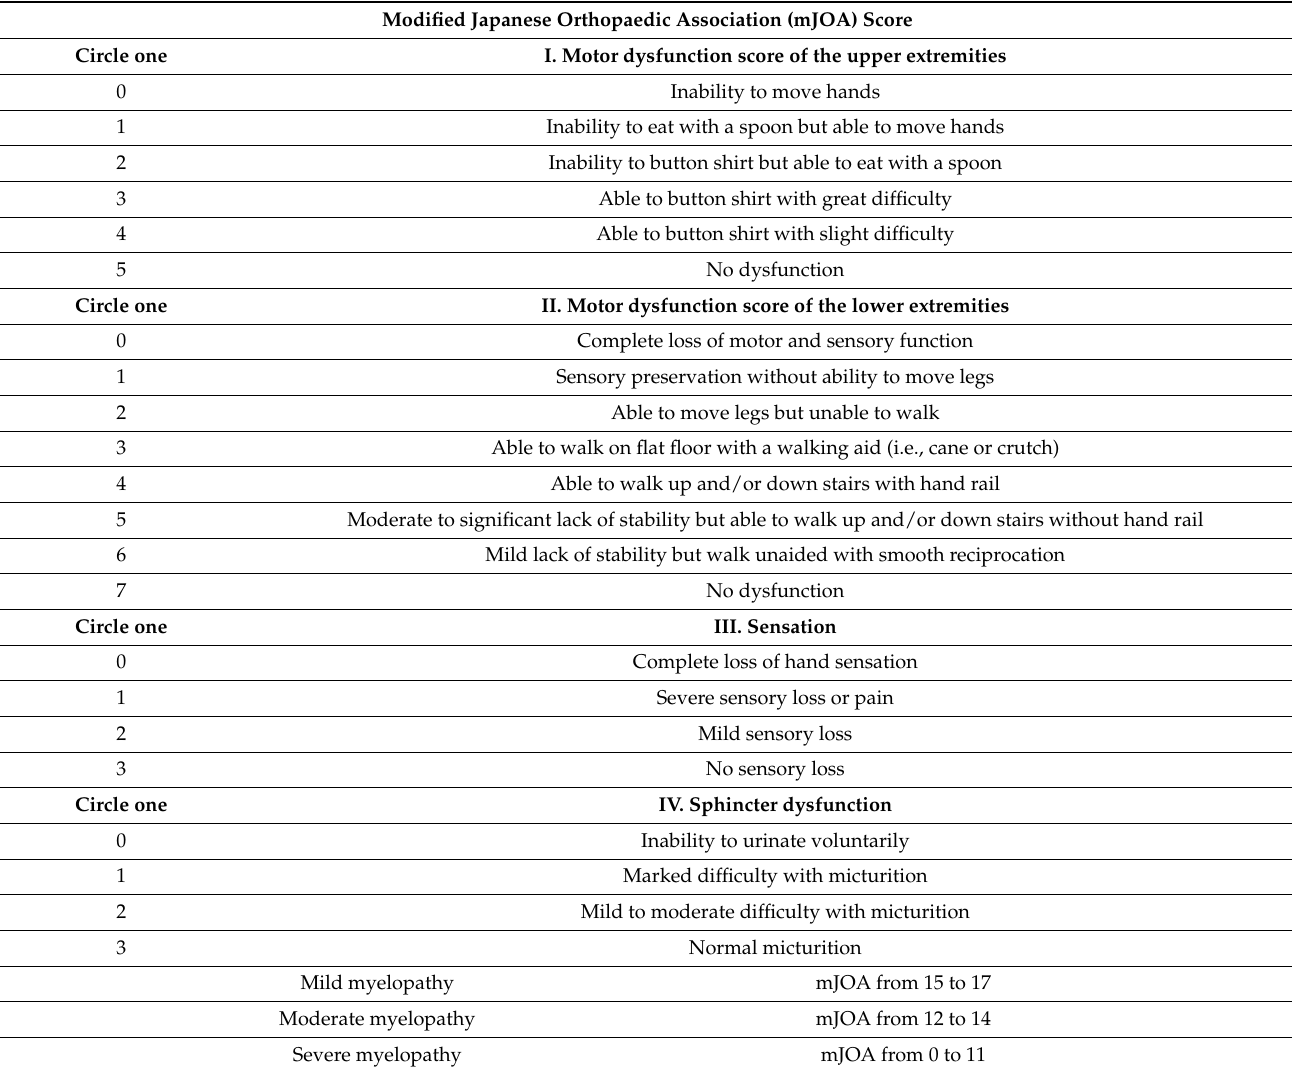
Table A1. Modified Japanese Orthopaedic Association (mJOA) Score